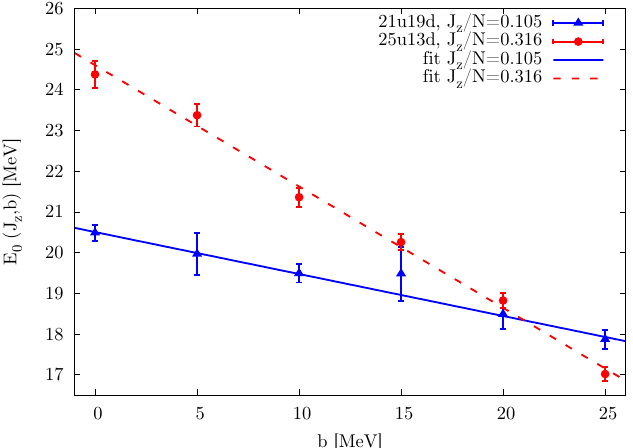
Figure 3. PNM energy per particle E 0 ( J z , b ) at saturation density at fixed spin asymmetry J z in two different cases: 21 spin-up neutrons N ↑ and 19 spin-down neutrons N ↓ (blue triangles), and 25 N ↑ and 13 N ↓ (red circles), which correspond to J z / N = 0.105 and J z / N = 0.316, respectively. Solid and dashed lines are linear fits that show the validity of assumption